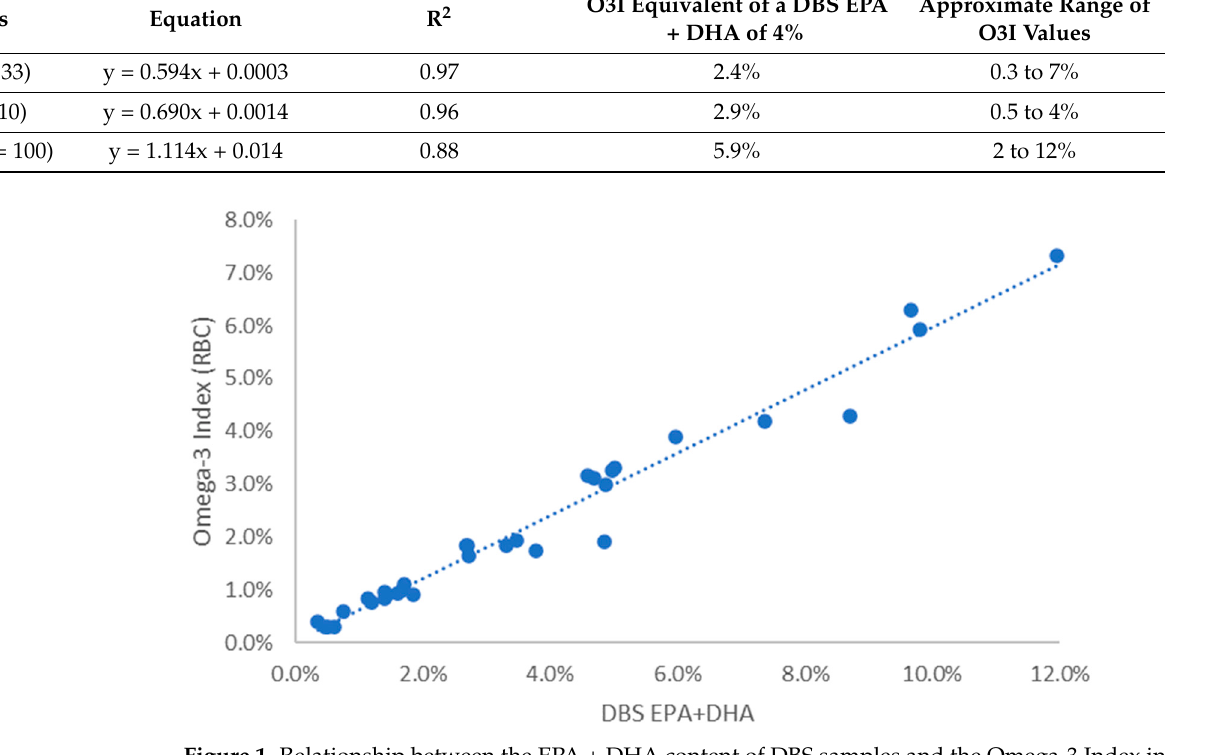
Table 1. Equations to convert DBS EPA + DHA (x) into the Omega-3 Index (RBC EPA + DHA %) (y) by species.